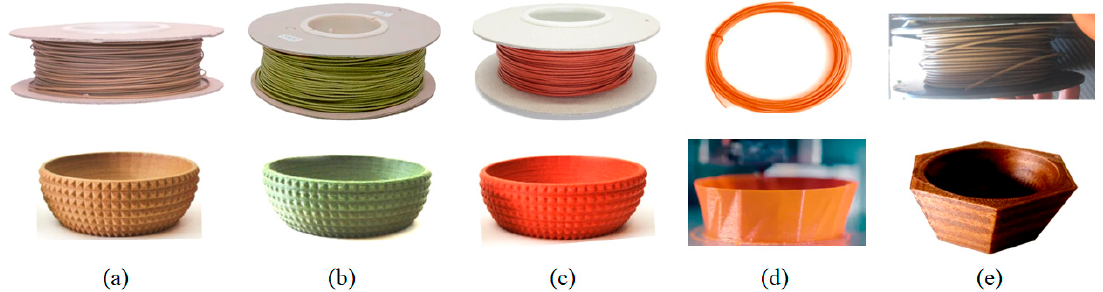
Figure 2. Thermoplastic bio-composite filaments: ( a ) HEMP, ( b ) WEED, ( c ) TOMATO, ( d ) CAROB, and ( e )